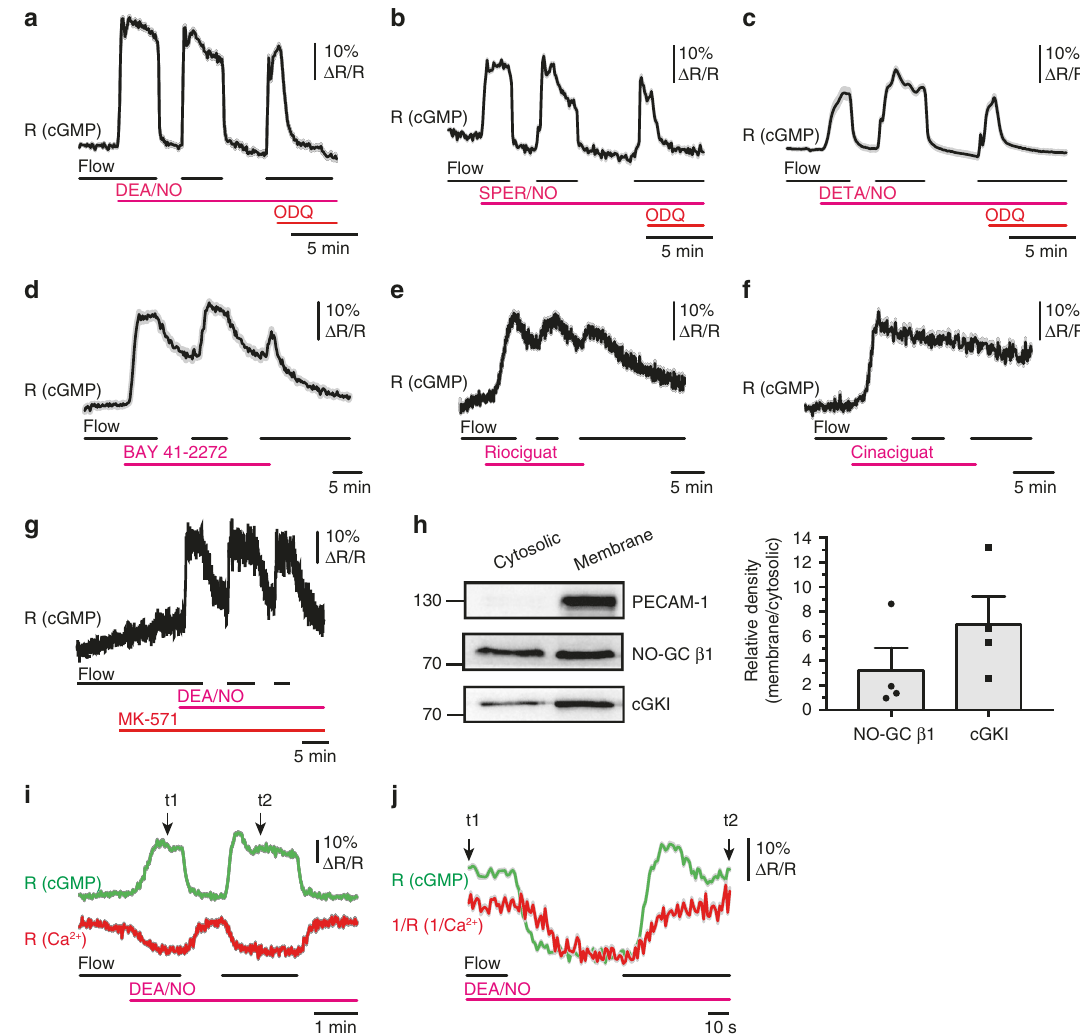
Fig. 2 NO-GC activity is regulated by fl uid shear stress and lowers the intracellular Ca 2 + concentration. FRET/cGMP imaging of cGi500-expressing platelet thrombi formed on collagen was performed under fl ow on (500 s − 1 ) and off (0 s − 1 ) conditions. a – c Thrombi were exposed to a DEA/NO (100 nM), b SPER/NO (500 nM), or c DETA/NO (10 μ M). At the end of each experiment, 20 μ M ODQ was applied in the presence of the respective NO donor and continuous fl ow. d – f Thrombi were superfused with the NO-GC stimulators d BAY 41-2272 (5 µ M) or e riociguat (5 µ M), or f with the NO-GC activator cinaciguat (100 nM). g DEA/NO (100 nM)-induced cGMP signals in the presence of the MRP4 inhibitor, MK-571 (1 µ M). Data are shown as mean ± SEM ( n = 18 thrombi in a , b , g ; n = 10 thrombi in c , d ; n = 15 thrombi in e , f ). h Western blot analysis of NO-GC β 1, cGKI, and PECAM-1 in cytosolic and membrane fractions of mouse platelets. Data are shown as mean ± SEM ( n = 4). i Simultaneous imaging of cGMP (green trace) and Ca 2 + (red trace) in the presence and absence of fl ow and 100 nM DEA/NO. These measurements were performed in the presence of 0.2 mM EGTA. Data are shown as mean ± SEM ( n = 25 thrombi). j Traces between time points t 1 and t 2 of i are shown with inverted Ca 2 + traces to facilitate analysis of the chronological order of changes in cGMP and Ca 2 + . Results are representative of three independent